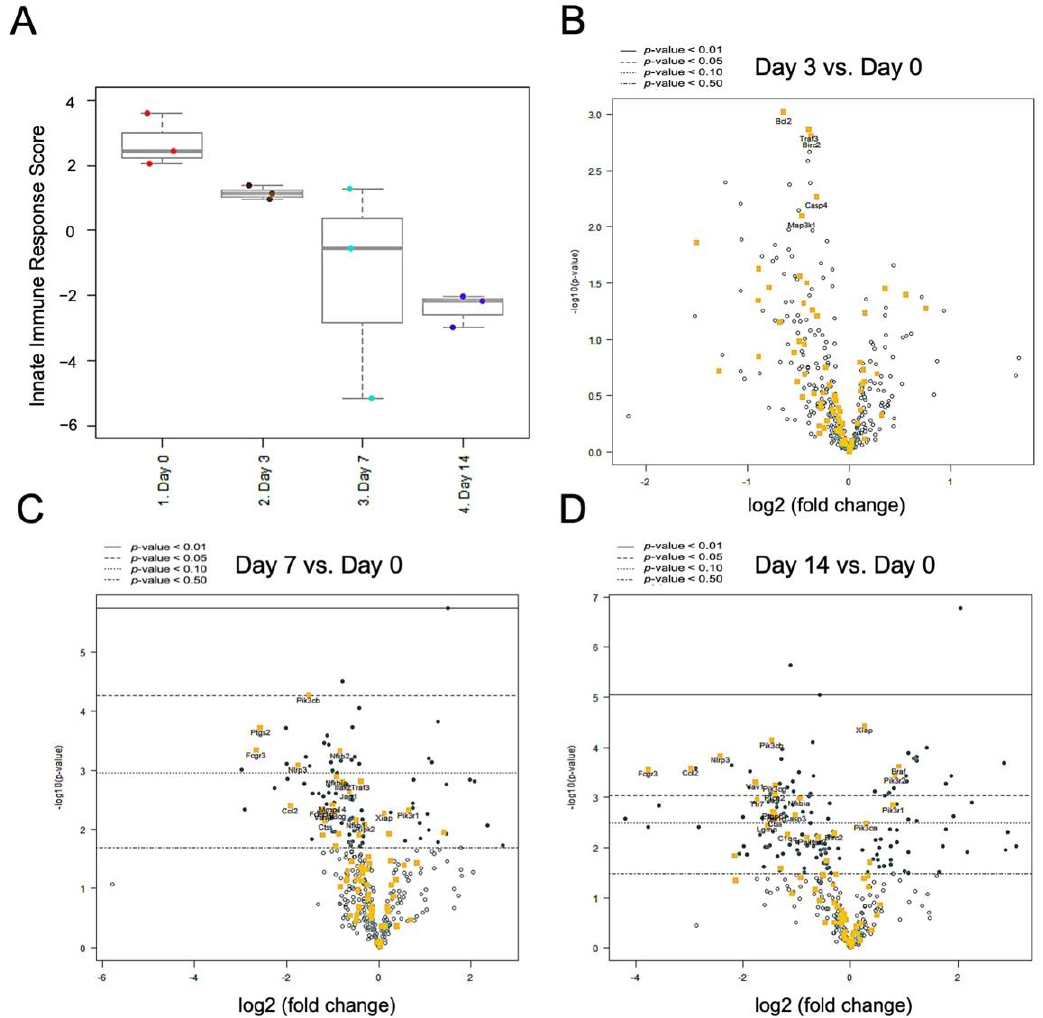
Figure 8. Differential gene expression in innate immune signaling in injured nerve. ( A ) NanoString nCounter innate immune signaling score revealed downregulation from day 0 to day 14. ( B – D ) Volcano plot of differential gene expression at day 3, day 7 and day 14, comparing with day 0. (N = 3 for each group).